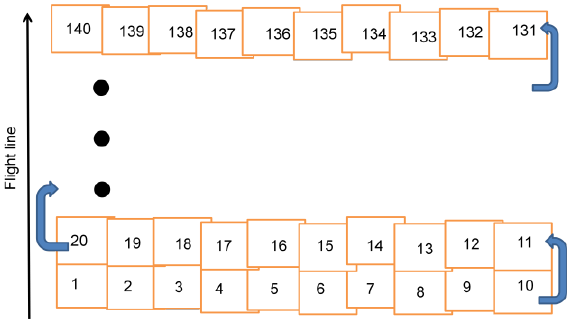
Figure 1. Image collection scene from the GH